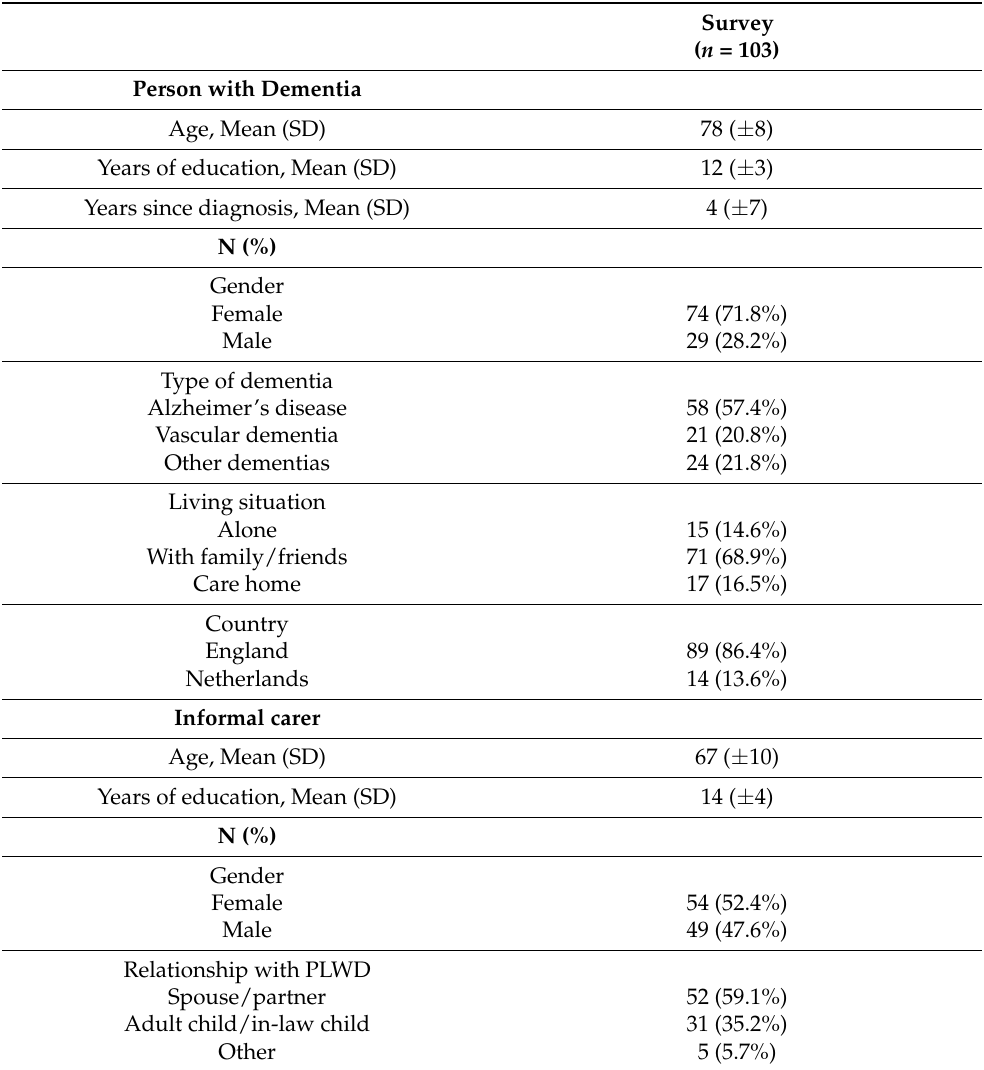
Table 1. Participant